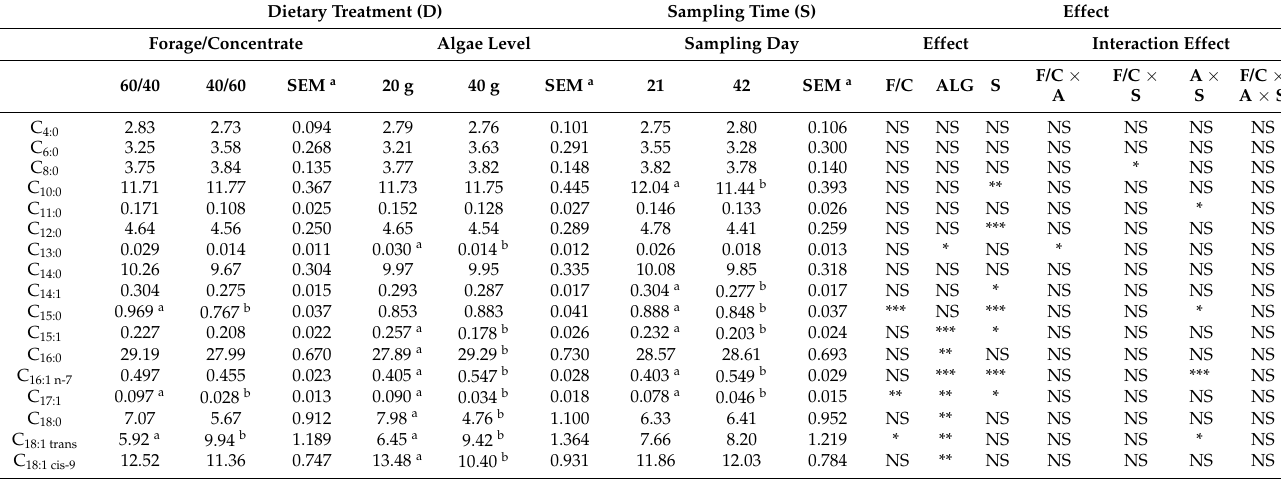
Table 5. The mean individual fatty acids (FA) (% of total FA), grouped FA, FA health indices, and ∆ -9 desaturase indices in the milk of goats fed diets (20 HF, 20 HG, 40 HF, and 40 HG) with different levels of Schizochytrium spp. (20 g and 40 g/goat/day) and two different forage to concentrate ratios (60:40 and 40:60) throughout the experimental period (21st and 42nd experimental